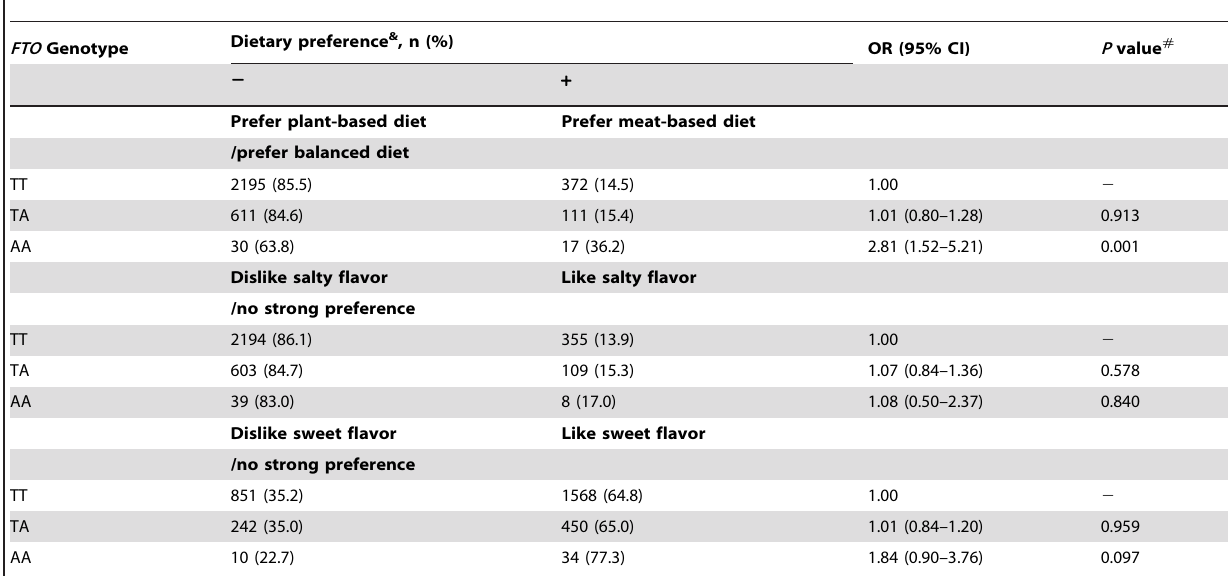
Table 4. Associations of the FTO rs9939609 genotypes with dietary preferences.